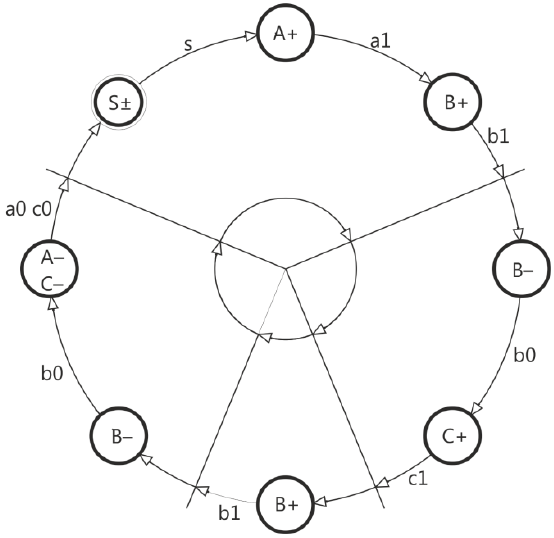
Figure 3. System graph.